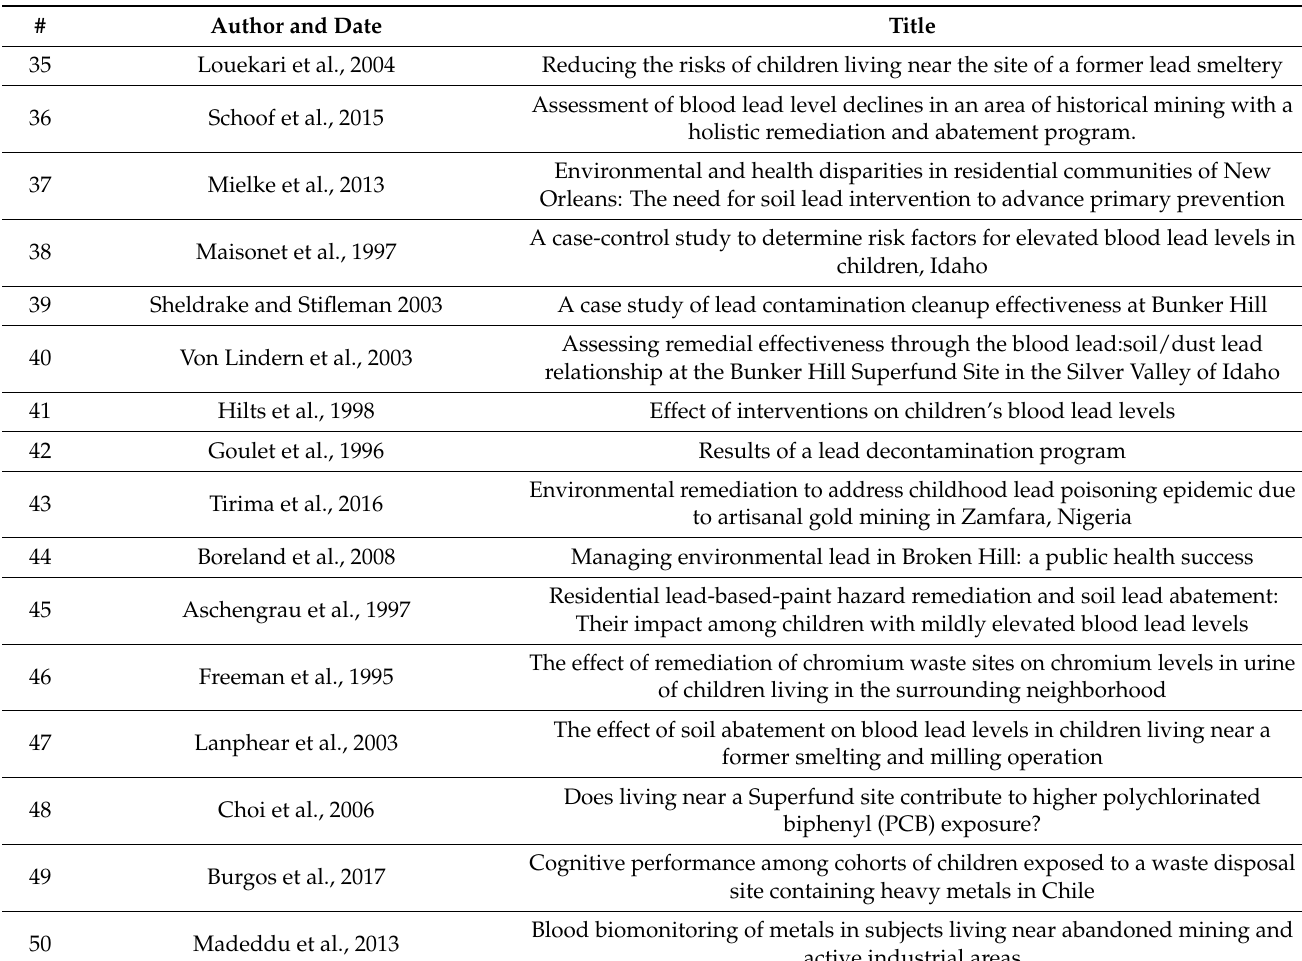
Table 2. Studies meeting eligibility criteria included in the systematic